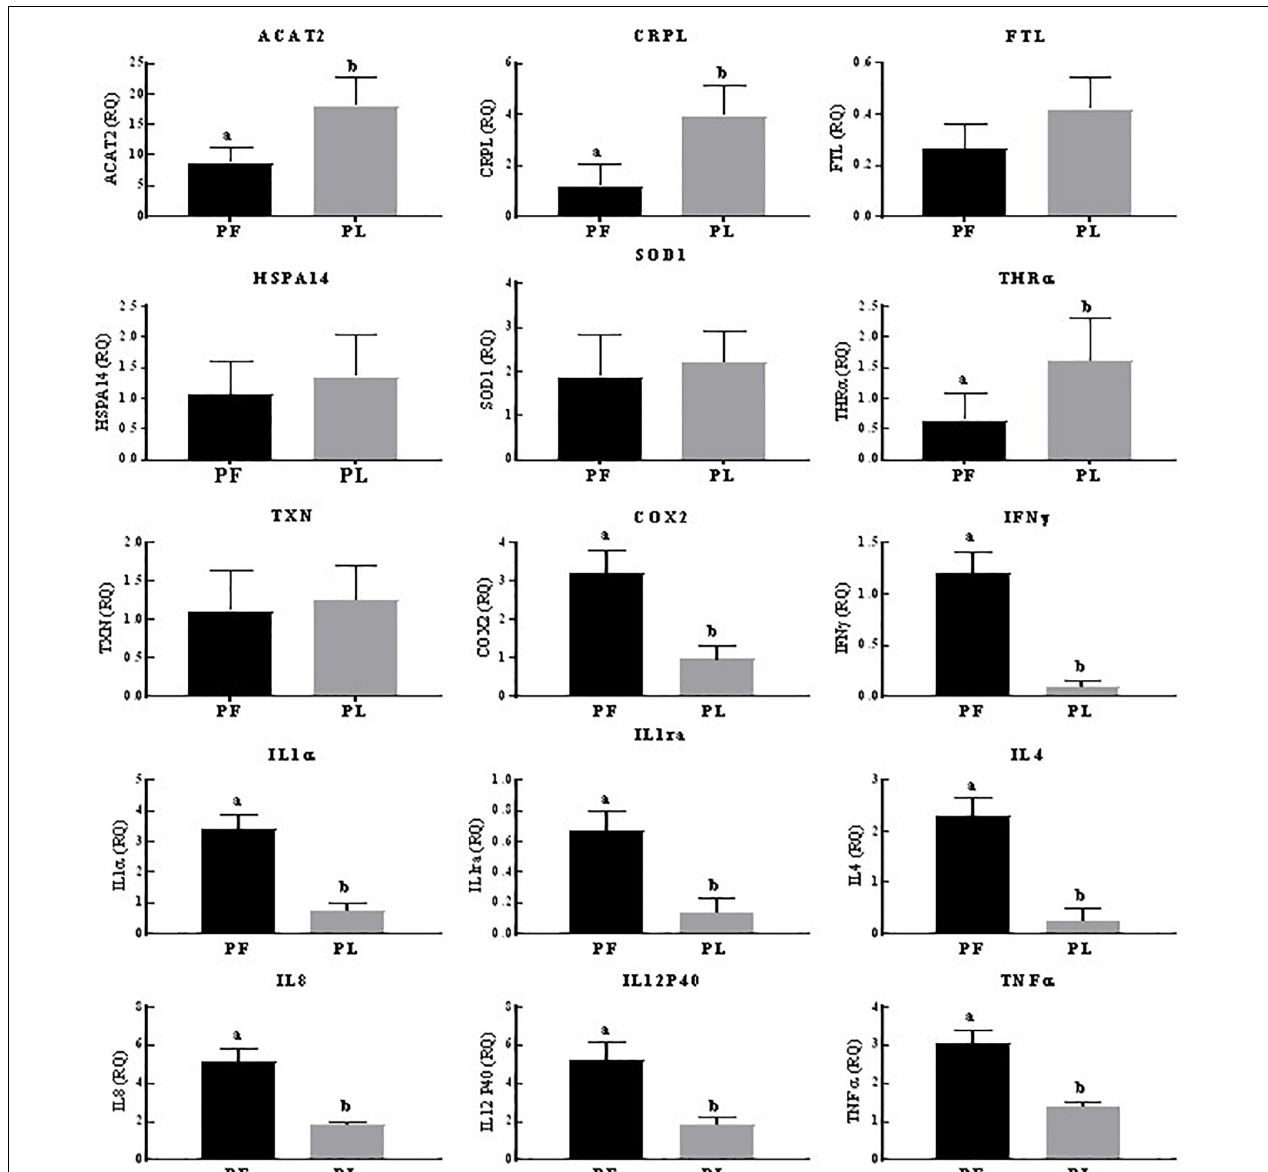
FIGURE 3 | Yangtze finless porpoises (YFPs) living in Poyang Lake across the reproductive status. Each parameter followed by an alternate letter was significantly different at P ≤ 0.05. PF, Pregnant female; PL, Pregnant plus lactating